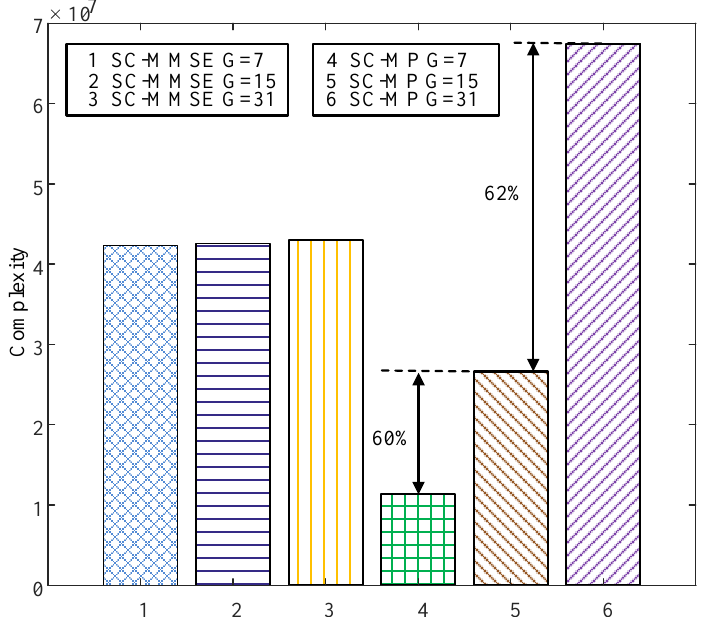
Figure 8. Complexity comparisons of the proposed SC-MMSE and SC-MP detectors for the GSTFIM systems with different numbers of effective subcarriers G in three